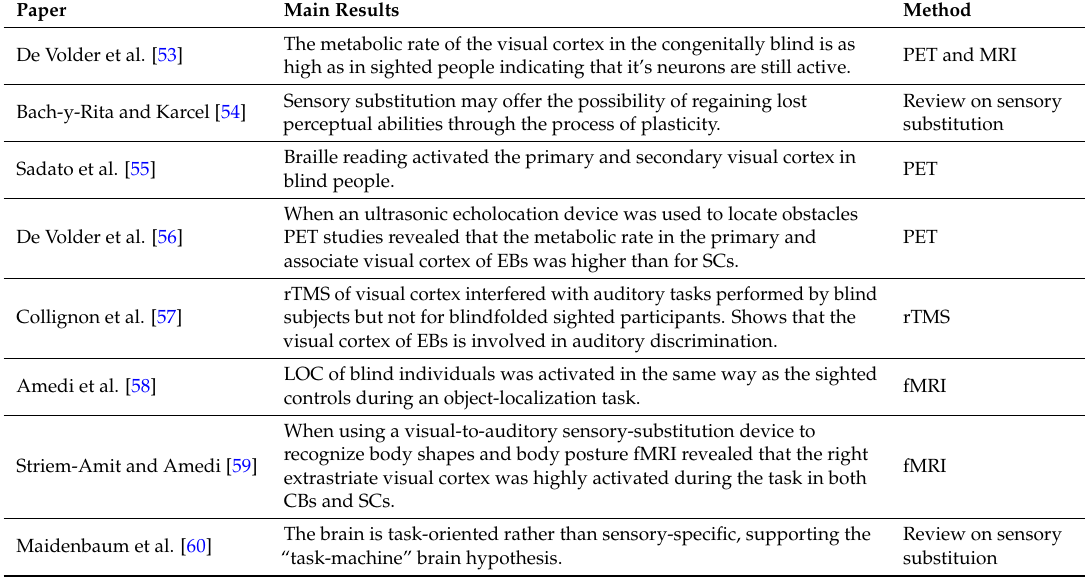
Table 3. Overview of the results reviewed in Section 4, Sensory